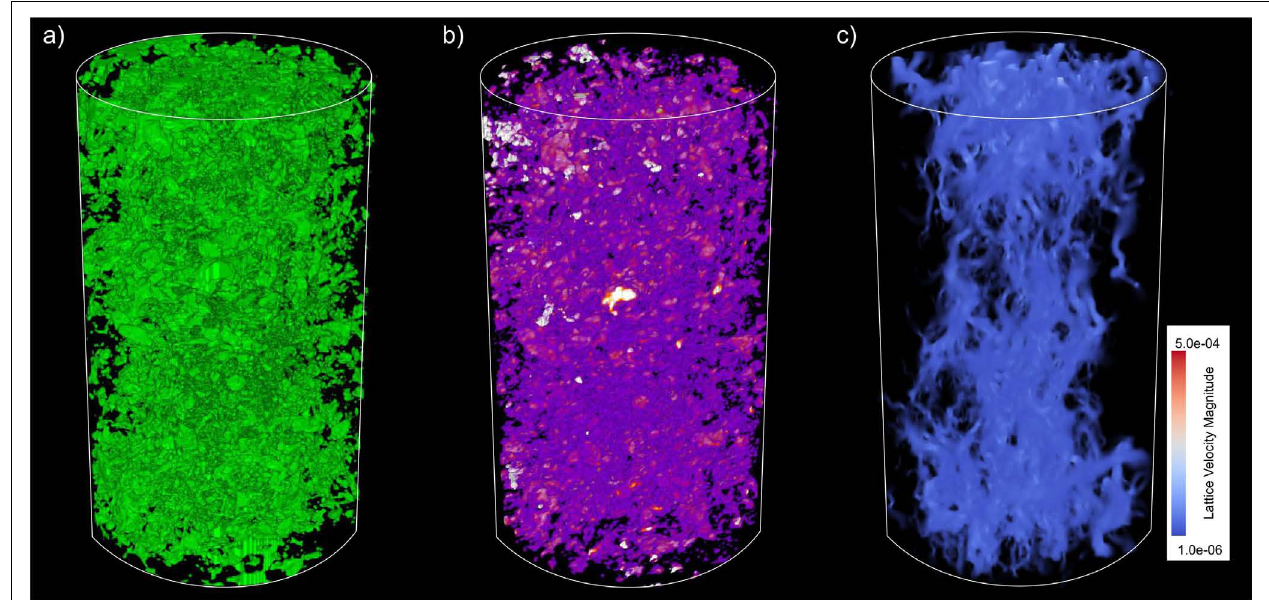
FIGURE 9 | Comparison of resulting 3D renderings of (a) Segmented pores from XCT (in green), (b) Difference of wet-dry NCT images, (c) Lattice velocity images obtained by LBM fluid flow simulation.The sample size is ca. 10 mm × 20 mm (diameter × height), whereas the pixel size was set to 13.5 µ m.